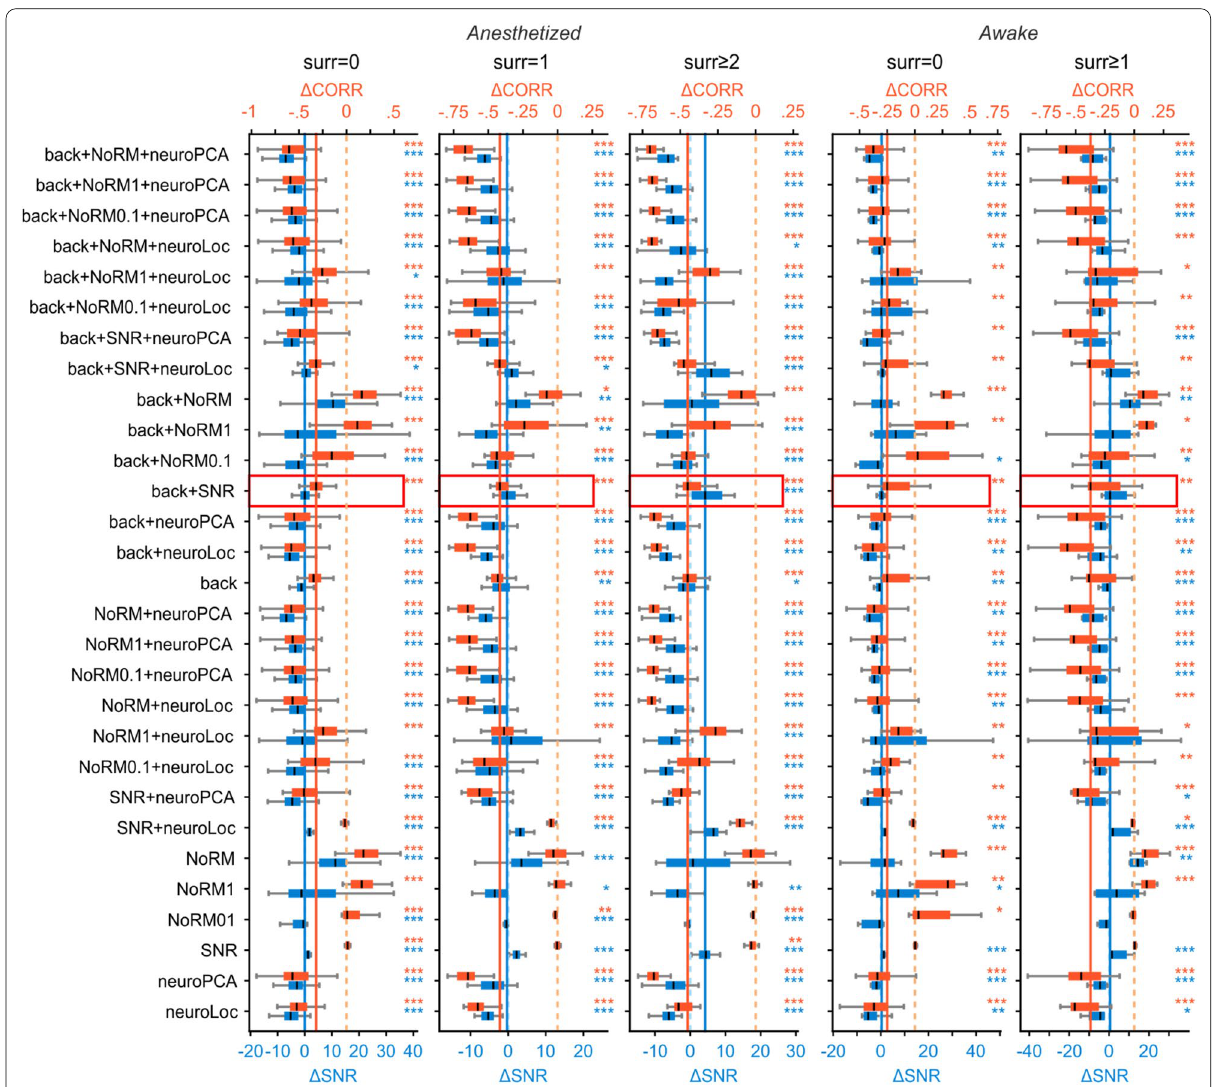
Fig. 6 Processing pipelines comparison. Evaluation of the signal quality after different processing pipelines for SLS with different surrounds in anesthetized (n 101, 33, 28 for surround 0,1, 2) and awake animals (n 16, 12 for surround 0, 1). Blue boxplots show the SNR distributions = ≥ = ≥ for each pipeline, red boxplots show the pairwise correlations distributions for each pipeline. The continuous blue and the orange lines show, respectively, the SNR and pairwise correlation median value for the processing pipeline composed by background subtraction followed by SNR-based artefacts correction (red box). The dashed light blue and light orange lines correspond to no changes in SNR and pairwise correlations, respectively, with respect to raw data. Extended values in Additional file 1: Table